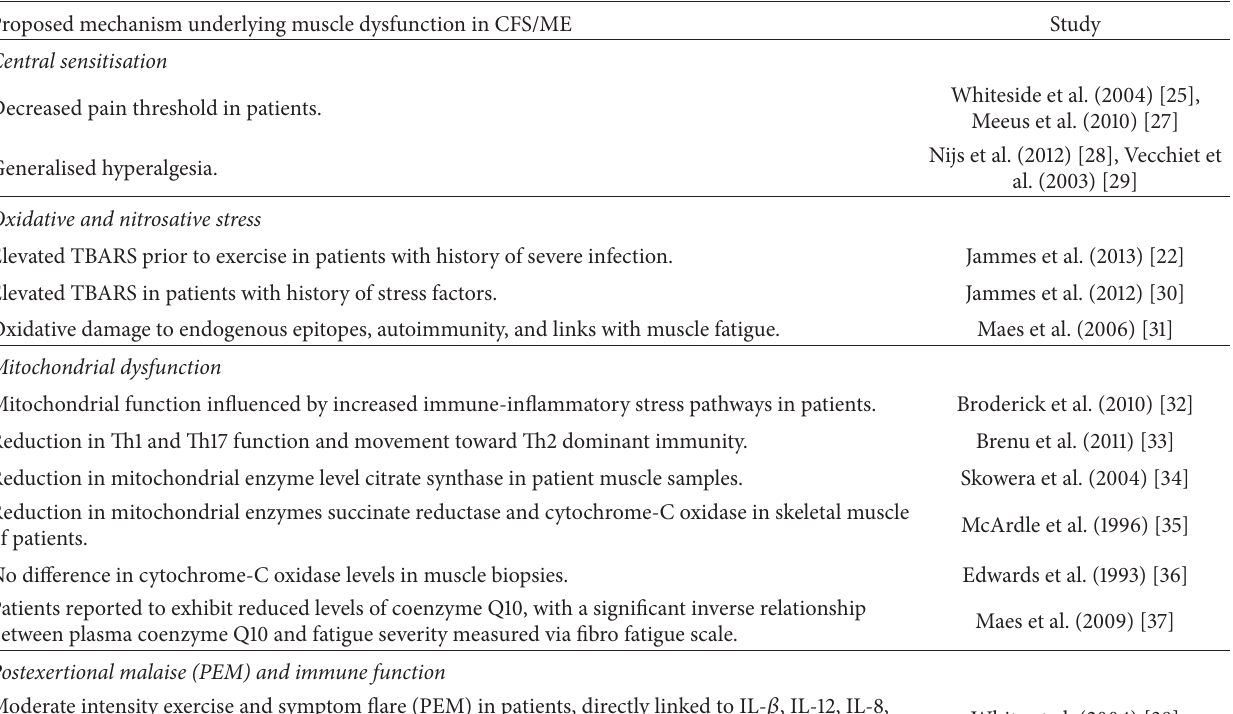
Table 1: Summary of various proposed mechanisms underlying muscle dysfunction in